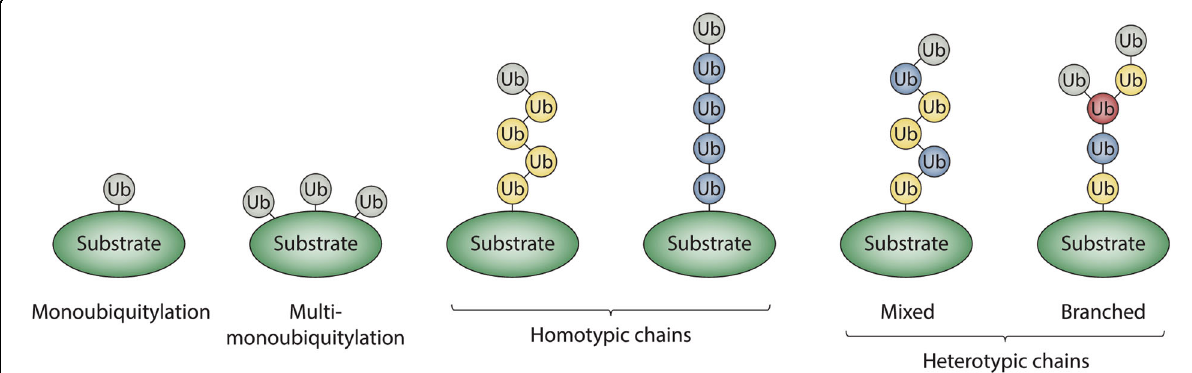
Fig. 1 Classi fi cation of ubiquitin modi fi cations. Protein substrates can be modi fi ed with ubiquitin monomers on one or more acceptor sites, referred to as monoubiquitylation or multi-monoubiquitylation, respectively. Alternatively, ubiquitin monomers can be joined to each other via isopeptide bonds to form chains of varying lengths, linkages, and structures. Homotypic chains are linked uniformly through the same acceptor site of ubiquitin (e.g., K48-linked chains), whereas heterotypic chains contain multiple types of linkages and can be further classi fi ed as either mixed or branched. Mixed chains consist of ubiquitin subunits that are modi fi ed on only a single acceptor site. Branched chains contain at least one ubiquitin subunit that is simultaneously modi fi ed on multiple acceptor sites. Ubiquitins modi fi ed on one acceptor site are colored in blue or yellow; the branch point ubiquitin is colored in red; unmodi fi ed or “ terminal ” ubiquitins are colored